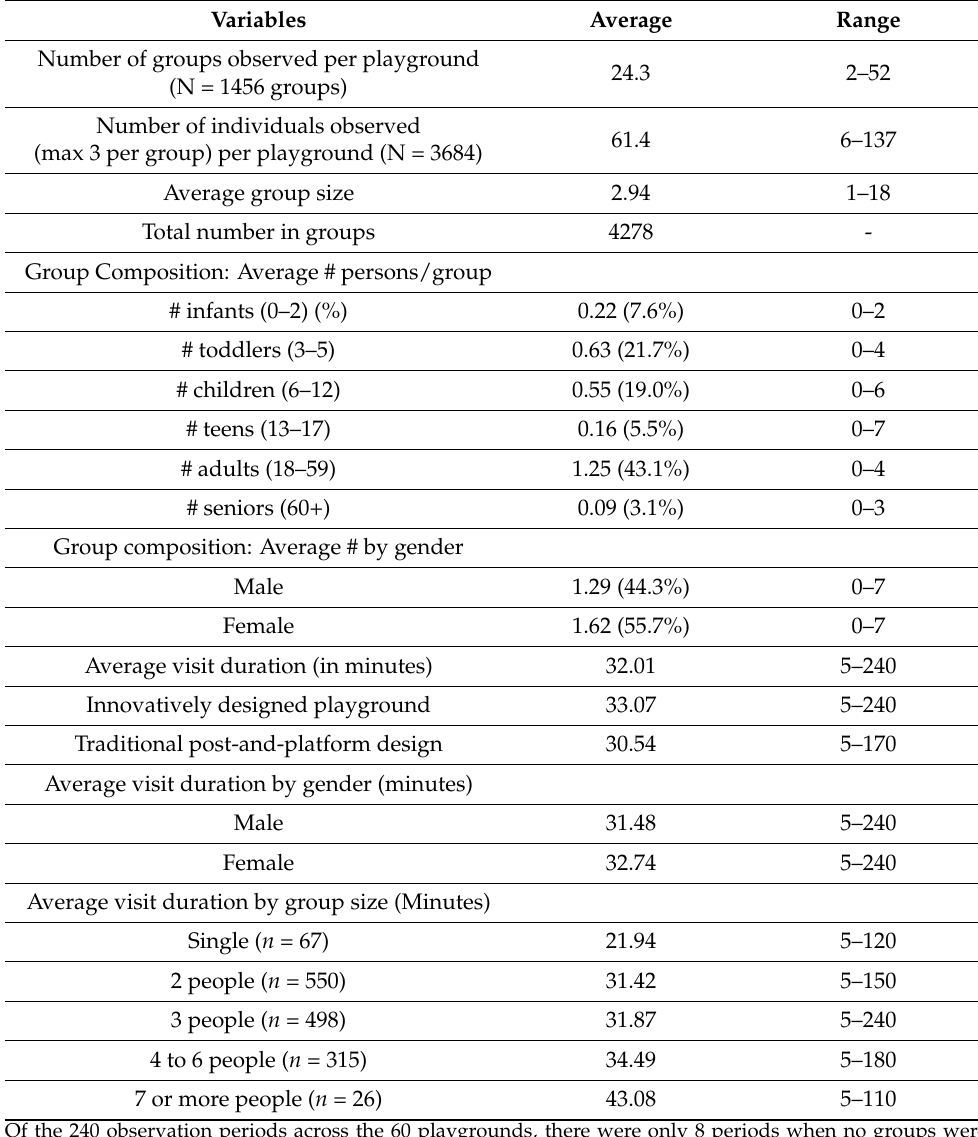
Table 2. Descriptive characteristics of visitors and time spent in